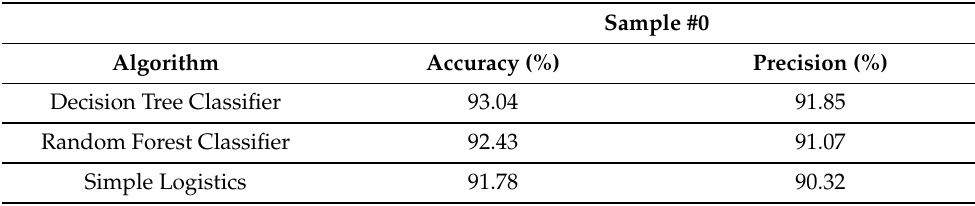
Table 5. Accuracy and precision for Sample #0.